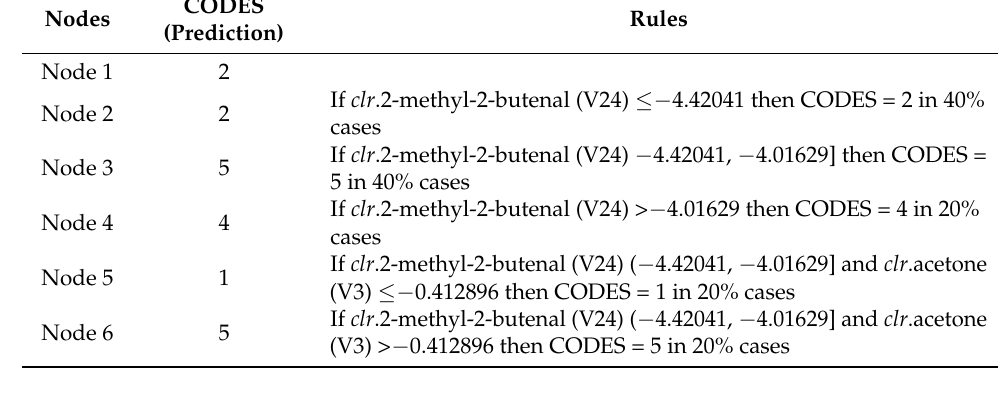
Table 1. Classification tree analysis. Rules for the classification of spoiled and normal Spanish-style Manzanilla fermentation samples. Codes are as follows: 1, butyric fermentations from industry A; 2, normal fermentations from industry A; 3, sulfidic spoilage from industry B; 4, putrid spoilage from industry B; and 5, normal fermentations from industry B.